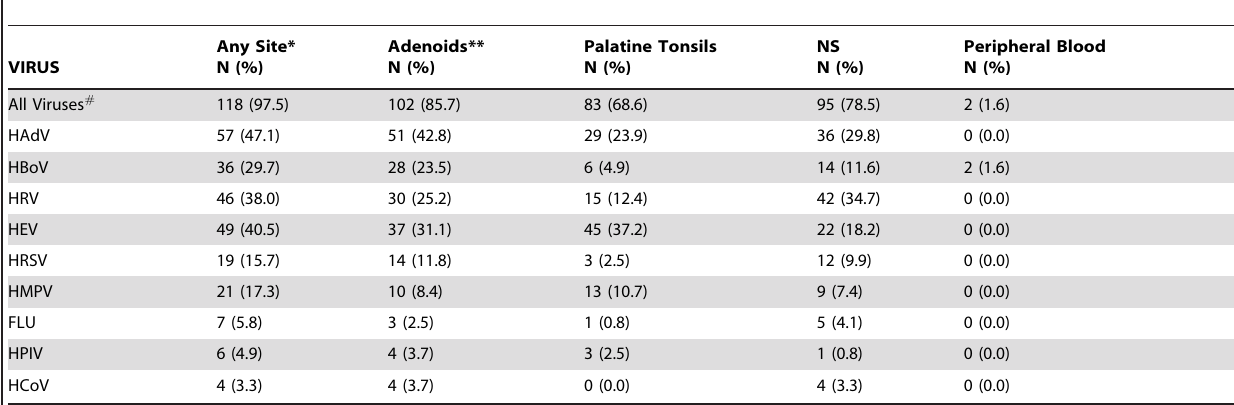
Table 1. Viral prevalence determined by qPCR in the different sample sites in 121 patients with chronic adenotonsillar disease.